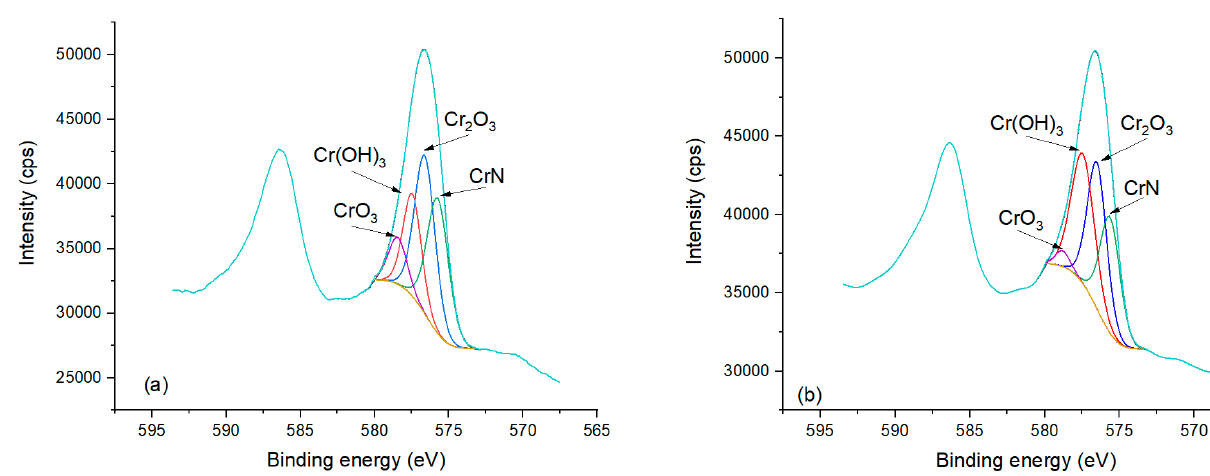
Figure 4. Cross-sectional analysis of oxy-nitrided AISI 304 SS with 20 wt% urea, viewed under the SEM at 5000× using secondary electrons.